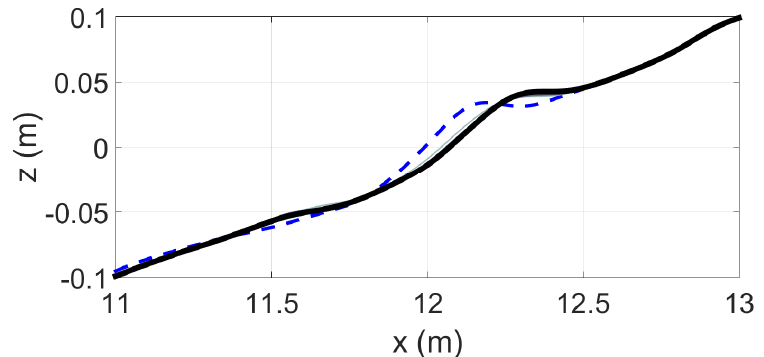
Figure 10. Profile evolution for the accretive wave case B. Initial (dashed blue), intermediate (thin grey) and final at t = 6 h (thick black) profiles. Note that small-scale sand ripples that are not resolved by the transport calculations have been filtered out from the profiles.